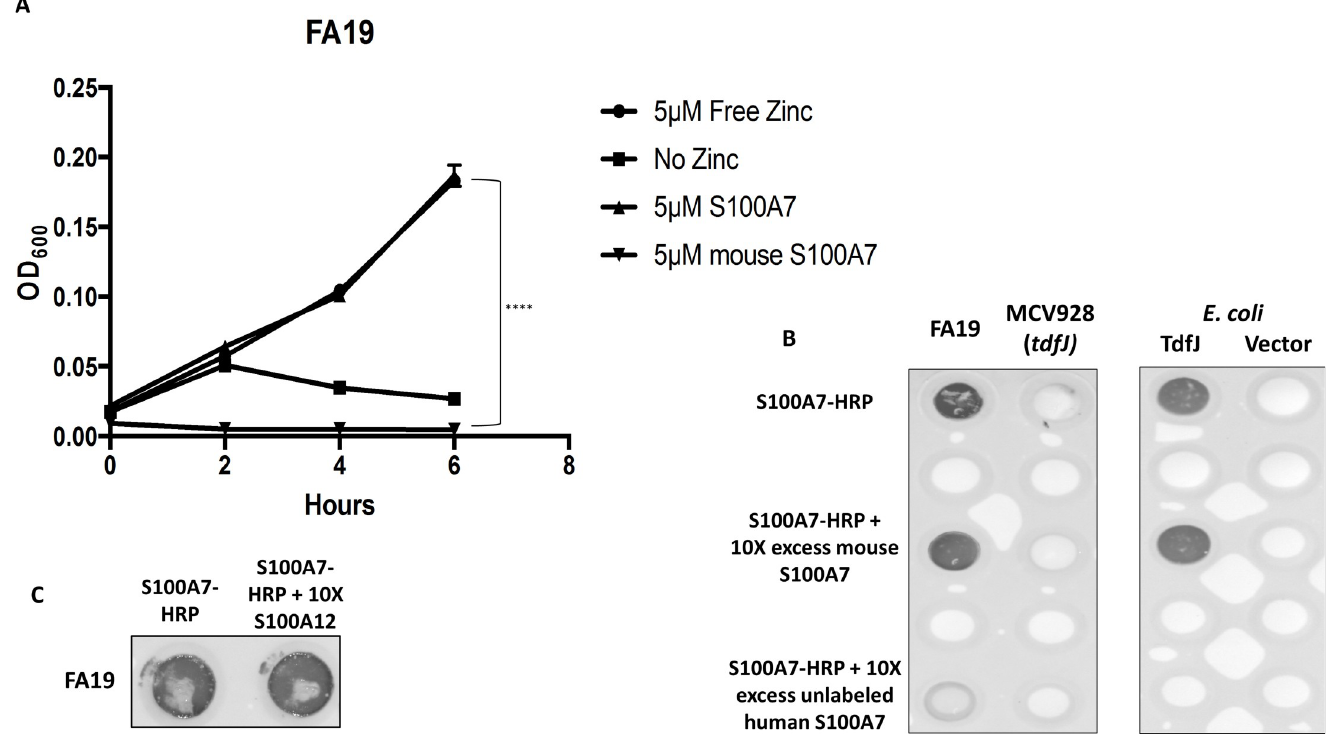
Fig 10. TdfJ utilization of and binding to S100A7 is specific for the human version of S100A7. (A) Strain FA19 was grown in Zn-restricted CDM supplemented with growth premix containing ZnSO 4 , human S100A7, mouse S100A7, or no zinc. OD 600 readings were taken every 2 h for 6 h total. Mean and SD for N = 3 experiments are represented in the graph. A 2-way repeated measures ANOVA with Tukey’s correction was performed for all means, with significance at 6 h shown. � , P � . 05; �� , P � .005; ��� , P � .0005; ���� , P � .0001 (B) Strain FA19 and MCV928 ( tdfJ ) were grown in Zn-restricted CDM supplemented with 24 μ M Fe(NO for 4 hours, after which equal culture densities were transferred to nitrocellulose in a dot blot apparatus. E . coli containing pVCU313 for TdfJ production or an empty pET-11a were grown in LB and induced for 4 h before being standardized to the same optical density used for gonococci and applied to nitrocellulose. Blots were then blocked and subsequently treated with HRP-labeled S100A7 either alone or with a 10-fold molar excess of unlabeled mouse or human S100A7 as competitor. Following this treatment blots were washed and colorimetric signal detection performed. (C) Strain FA19 was grown as described in part (B) before being standardized and dotted onto nitrocellulose. After blocking, blots were probed with either HRP-labeled S100A7 alone or in the presence of 10-fold molar excess of unlabeled S100A12, and signal was detected after washing. Blots shown are representative of N =